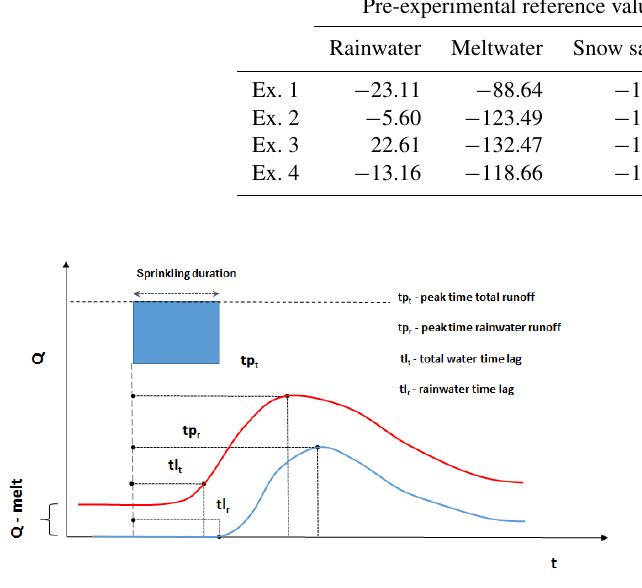
Figure 3. Graphical definition of peak times and time lags. authors do not assume any fractionation between solid and liquid phase during the